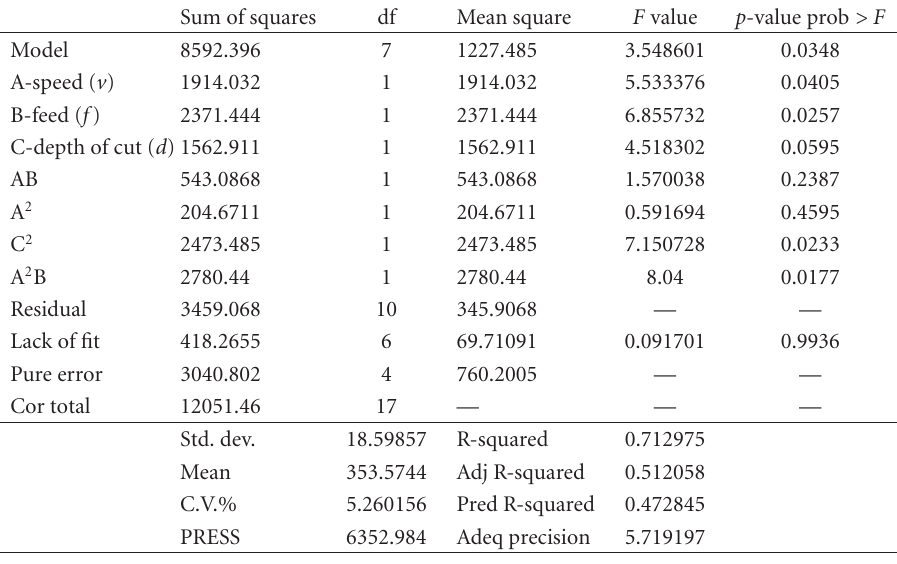
Table 6 . 3 . ANOVA for response surface reduced cubic chip microhardness model.